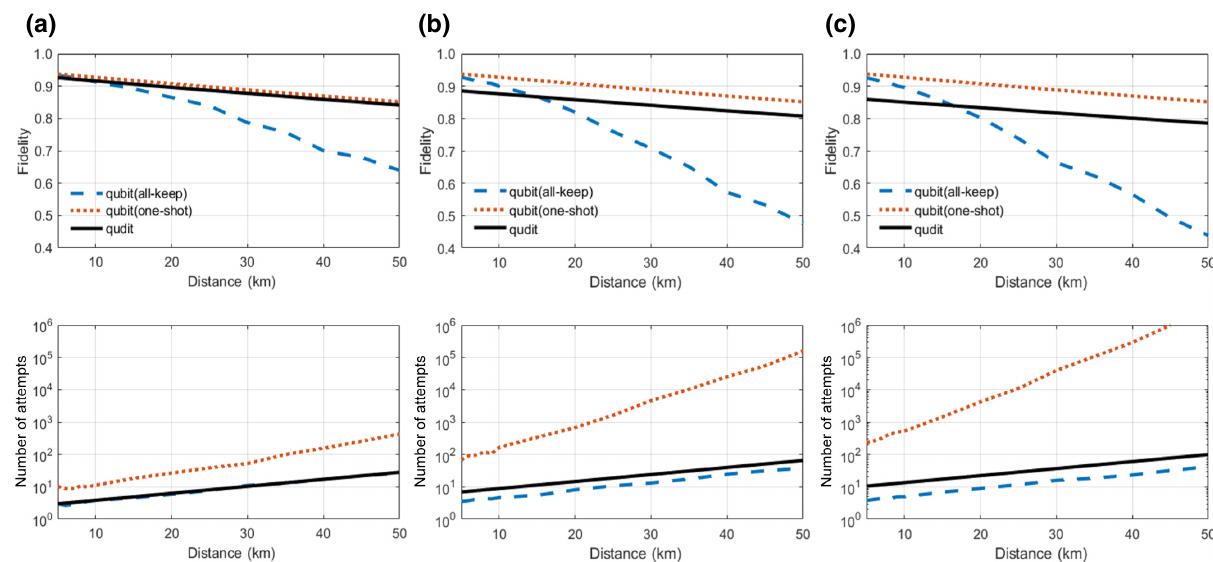
FIG. 4. A performance comparison between the qudit protocol and the comparative qubit protocol for the generation of (a) m = 2, (b) m = 4, and (c) m = 5 entangled pairs. The performance metrics are the average fidelity of the entangled pairs and the average number of attempts needed until the successful generation of all pairs. The fidelity is calculated as the average fidelity per Bell pair when tracing over the other spin qubits. For the qubit protocols, “all-keep” means the practical strategy where successful pairs are stored until all pairs have been generated and “one-shot” means the strategy where all entangled pairs are required to be generated simultaneously. We assume that the time of local operations is negligible, such that the rates of both the qudit and qubit protocols are set by the signaling time between the two distant registers. The simultaneous attempt of all links in the qubit protocol is counted as one